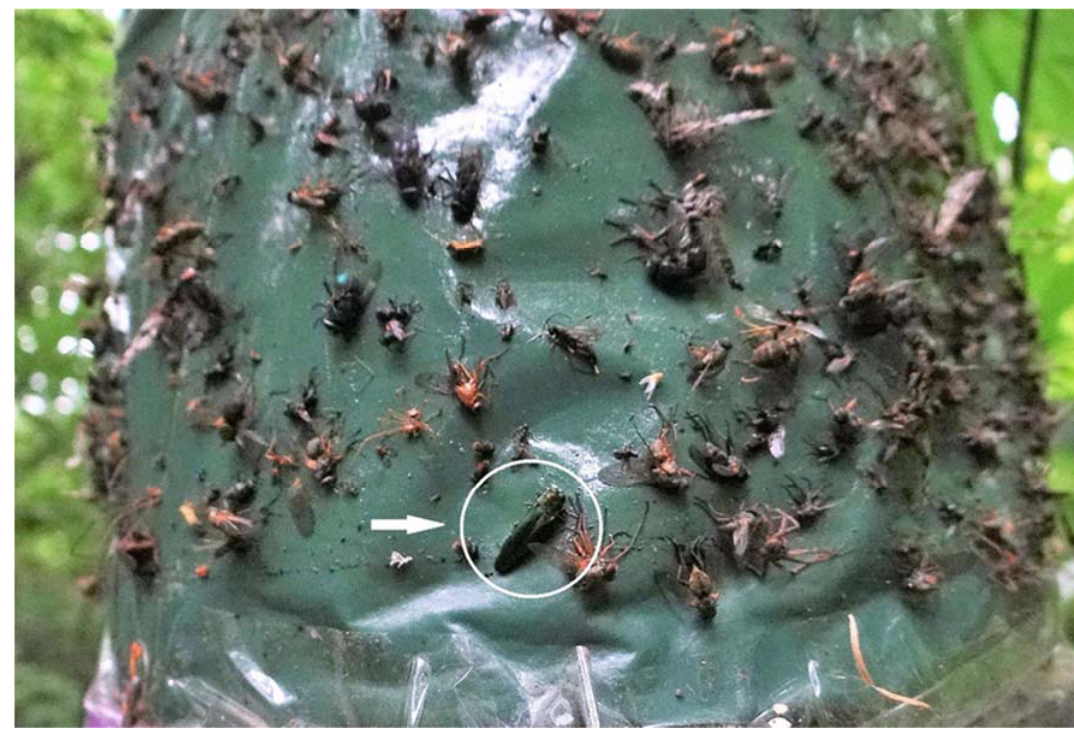
Figure 3. An adult of A. planipennis (circled) glued to the dark-green sticky belt and collected on 18 July 2018 among other glued insects. Photo by E. Y. Peregudova.